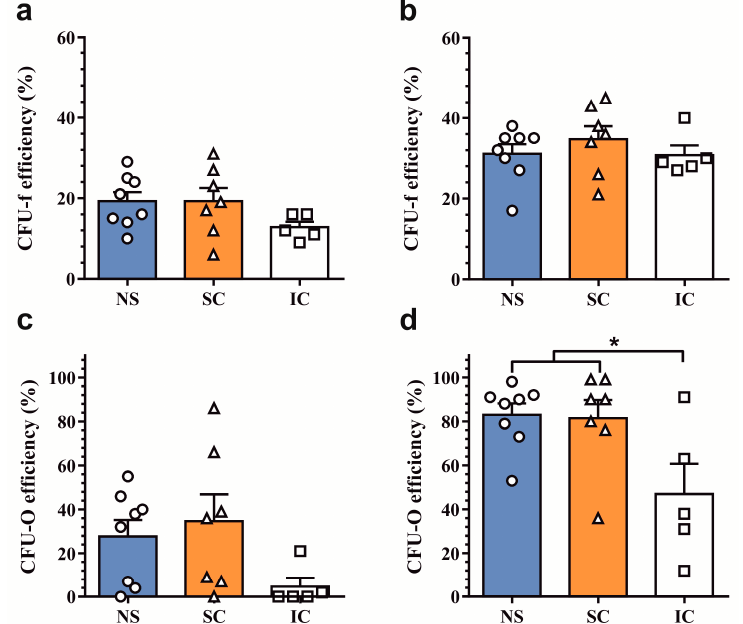
Figure 1. Assessment of clonogenic and osteogenic potential of osteoprogenitors from non-sclerotic (NS) and sclerotic (SC) osteoarthritic subchondral bone and non-osteoarthritic controls from iliac crest (IC). Efficiency of fibroblastic colony forming unit (CFU-f) formation in ( a ) complete and ( b ) osteogenic medium. Osteogenic potential (CFU-O), assessed as the percentage of alkaline phosphatase (ALP)-positive CFU-f colonies in ( c ) complete and ( d ) osteogenic medium. Data are presented as scatter dotplot with means + SEM, * p < 0.05 by one-way ANOVA.